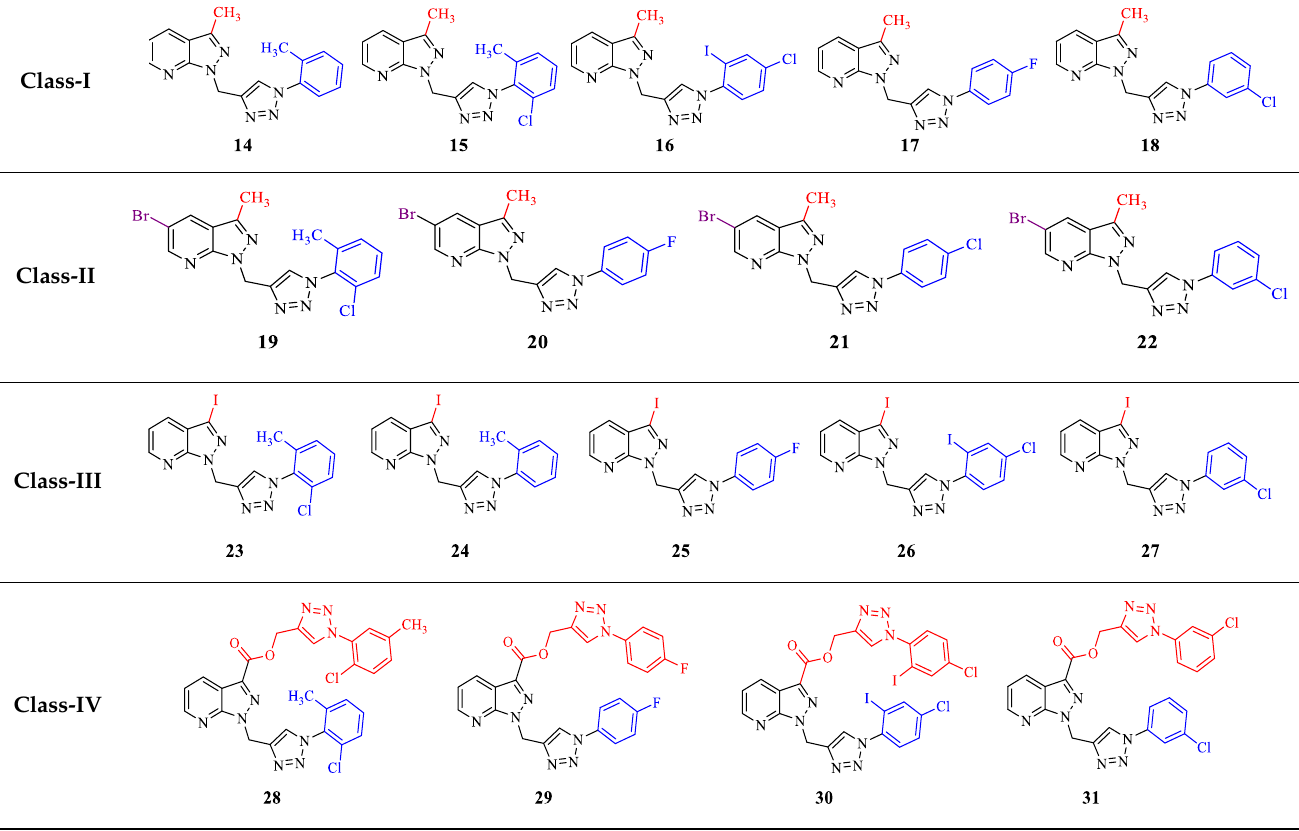
Table 2. The Physico-chemical and biological properties of pyazolo[3,4- b ]pyridine and triazole mo- lecular hybrids.